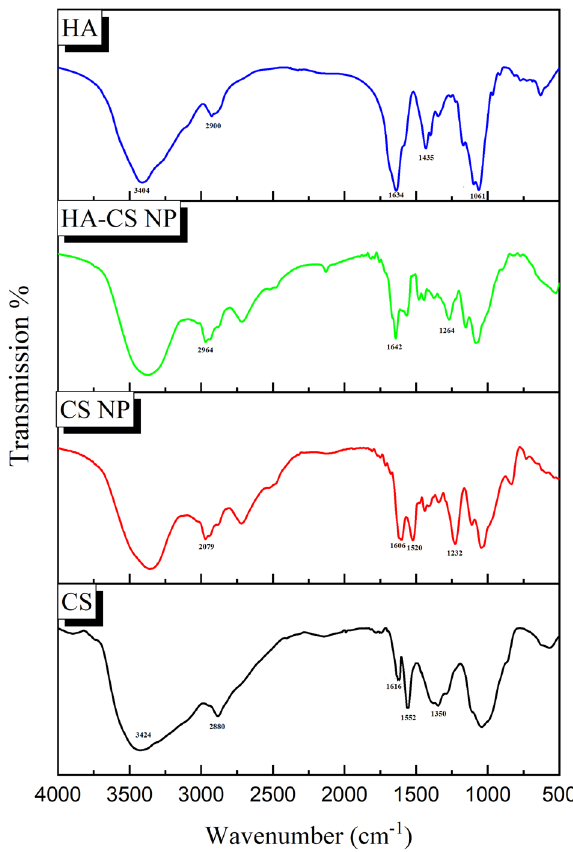
Fig. 1 FTIR spectra of chitosan (CS), chitosan nanoparticle (CS NP), hyaluronic acid-coated-chitosan nanoparticle (HA-CS NP), and hya- luronic acid